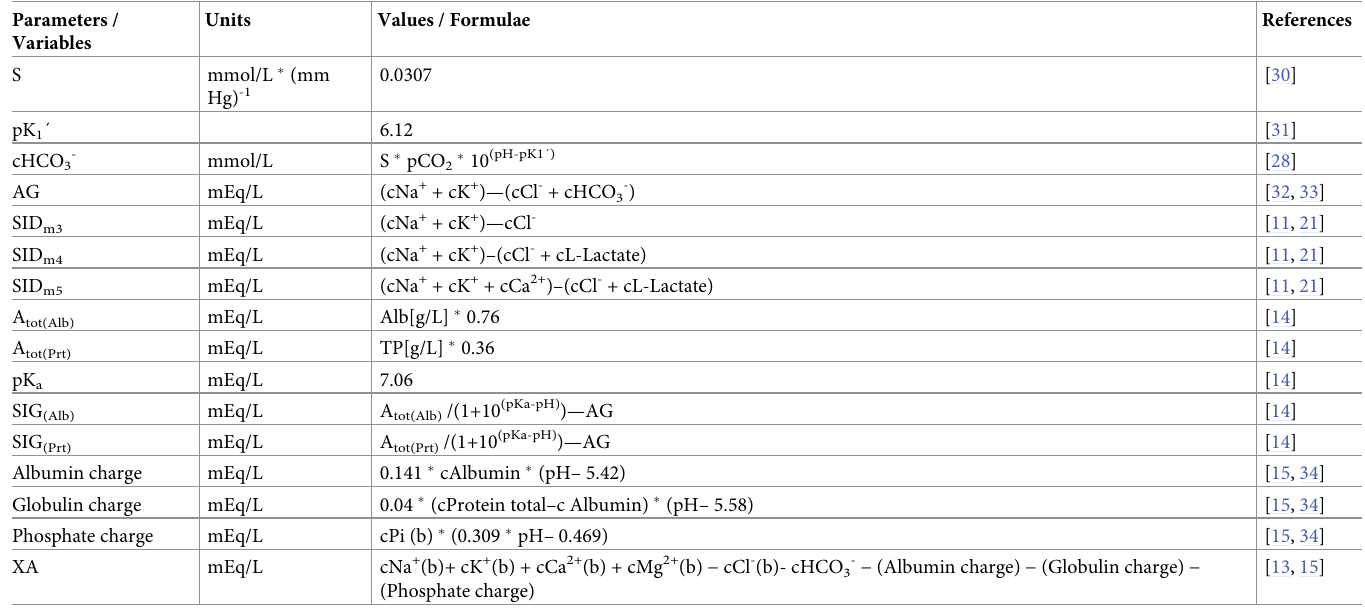
Table 1. Description of applied parameters and variables of acid-base equilibrium in blood. Parameters /